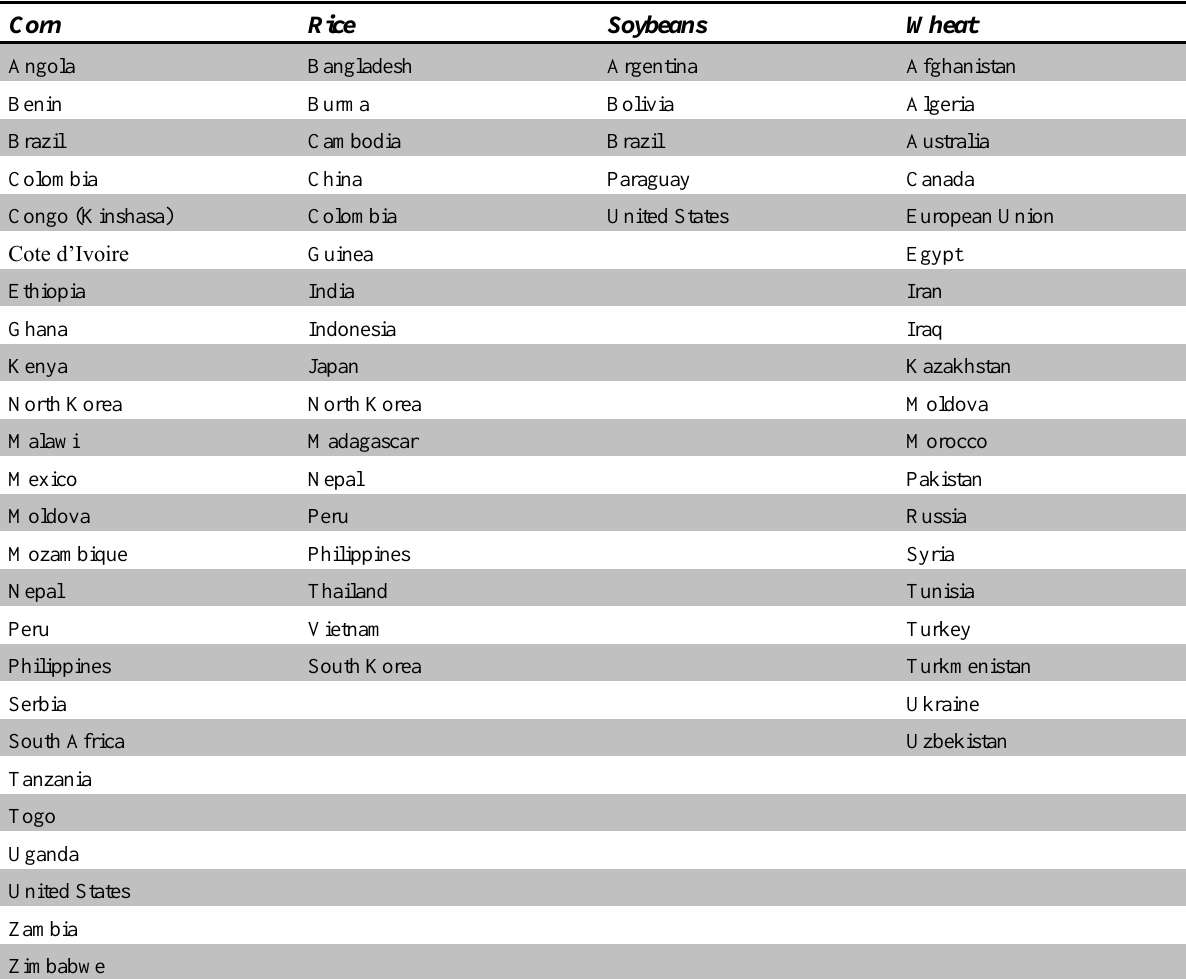
Table 5. Countries with at least 25% of cropland allocated to a single crop for the four dominant food production